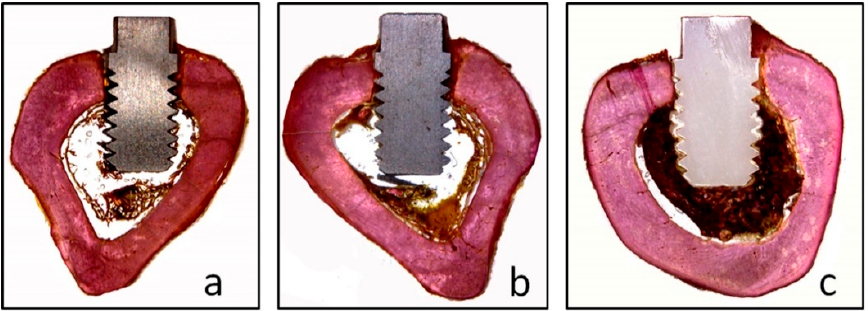
Figure 6. Images of the implants installed in the tibia of the three groups, ( a ) TiM group, ( b ) TiT and ( c ) Zr group.